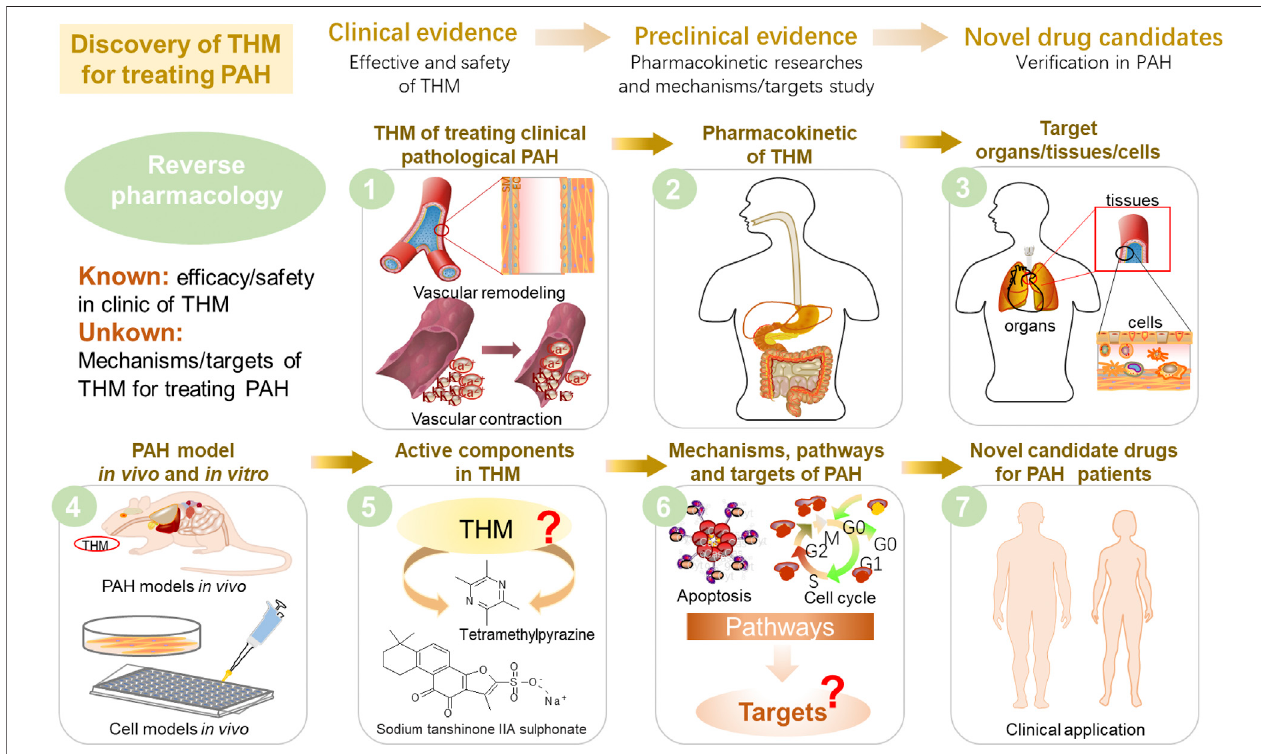
FIGURE 6 | Proposal of reverse pharmacology to discover potential new drug candidates derived from THM that can treat PAH.